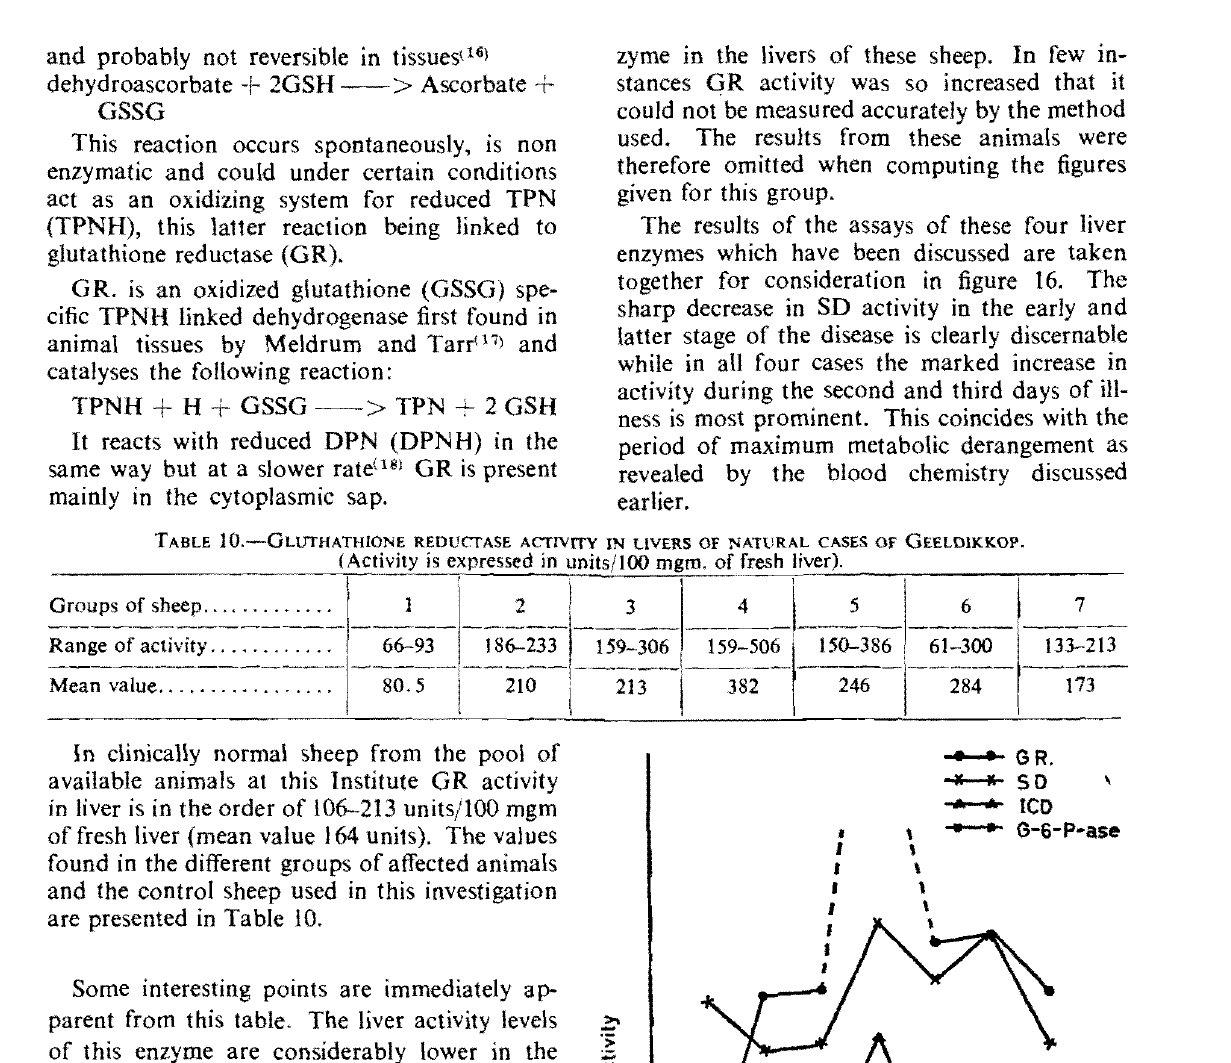
Schematic representation of the levels of activity of glutathione reductase (GRO). succinic dehydrogenase (SO). isocitric dehydrogenase (ICD) and g\ucose-6-phosphatase \ G-6-P-ase) in the livers of typical cases of